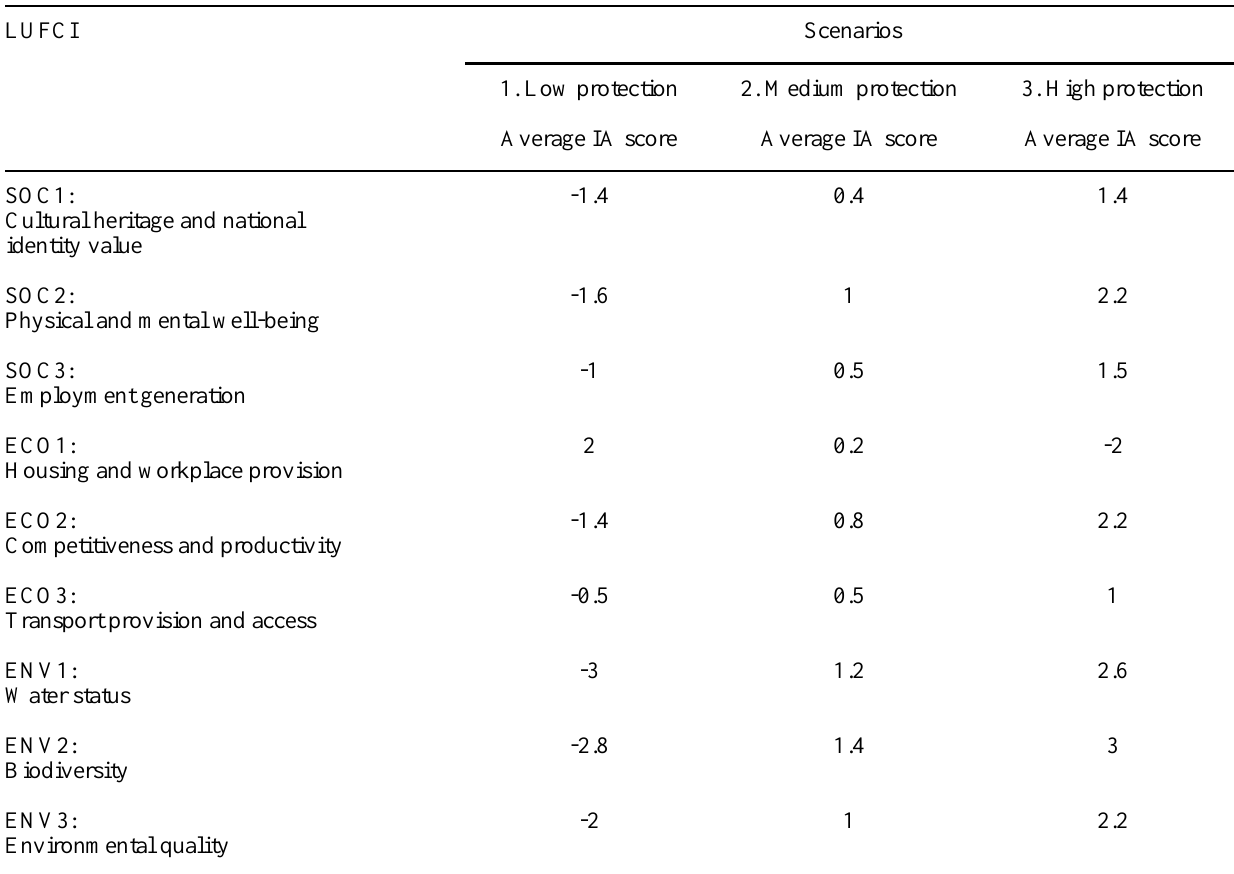
Table 5 . Impact assessment of biodiversity policy scenarios in Malta